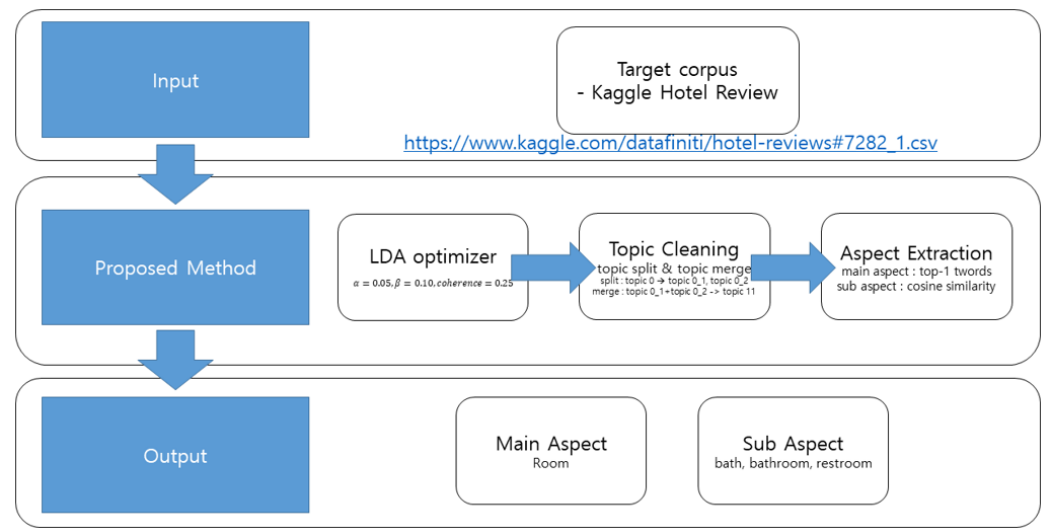
Figure 1. The overall system of the proposed